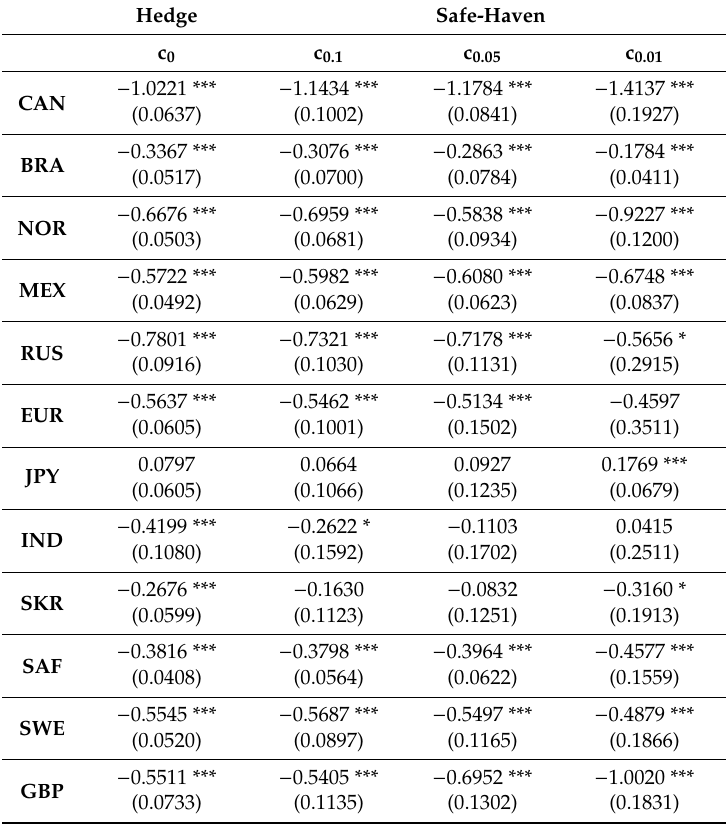
Table 2. Safe-haven and hedging function of crude oil.